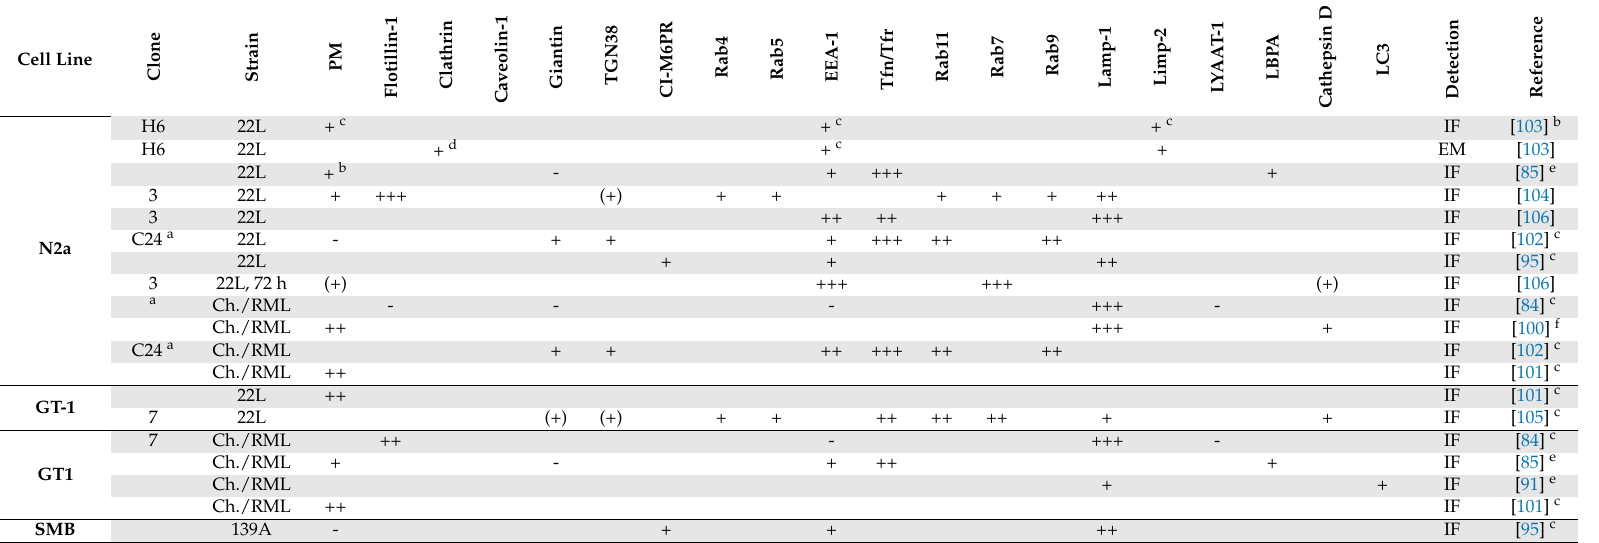
Table 2. Cellular localization of PrP Sc